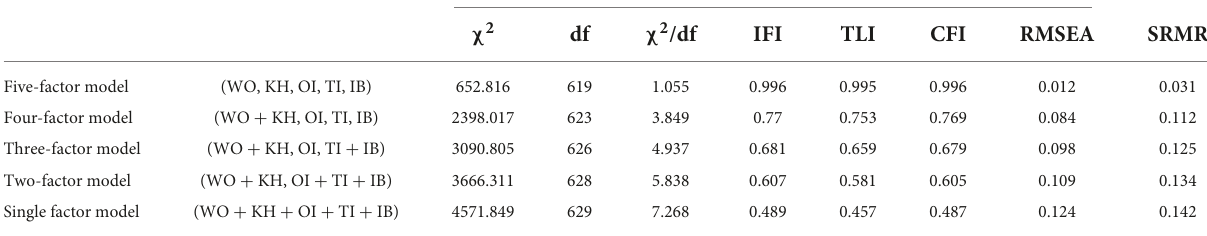
TABLE 2 Comparison of model